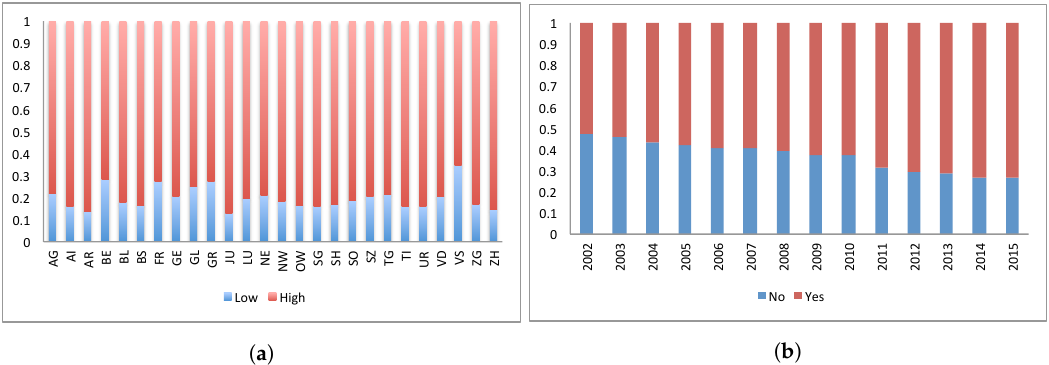
Figure 11. DRPC versus DMS in selected cantons.